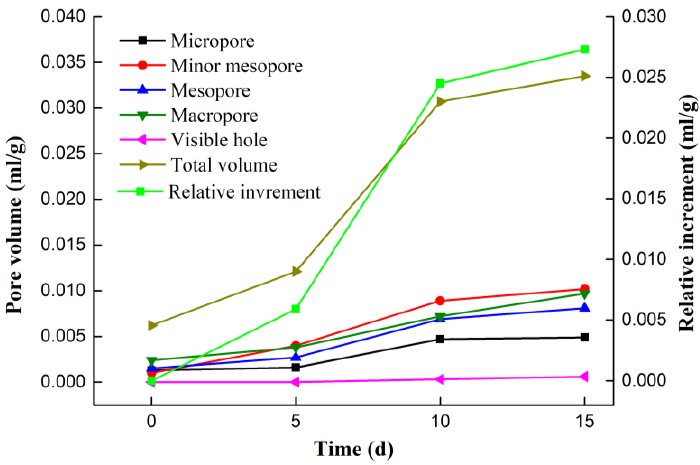
Figure 3. Curves of all types of pore volume of coal samples before and after soaking.